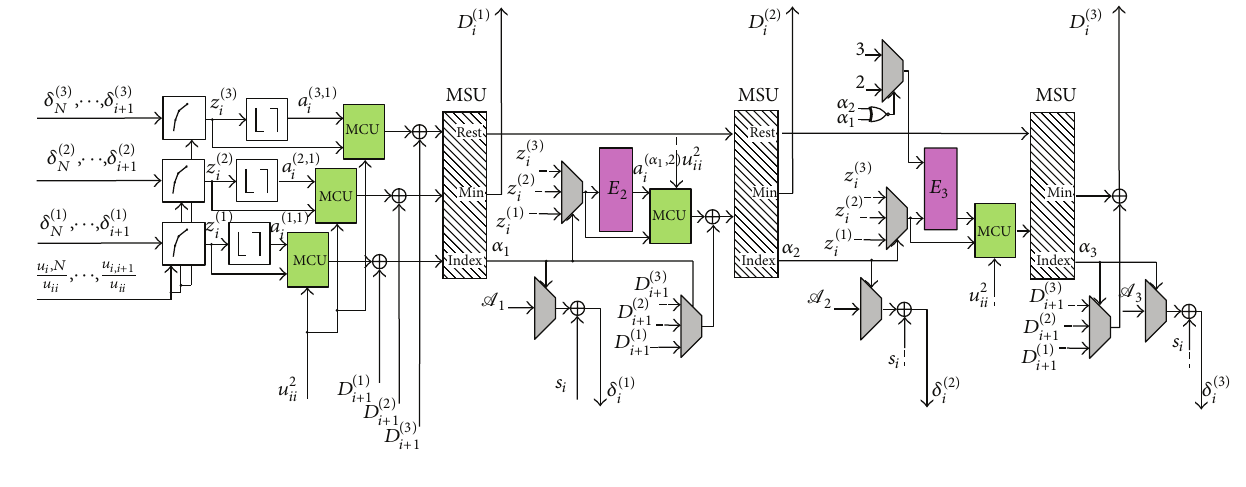
Figure 4: Block diagram of the K -best